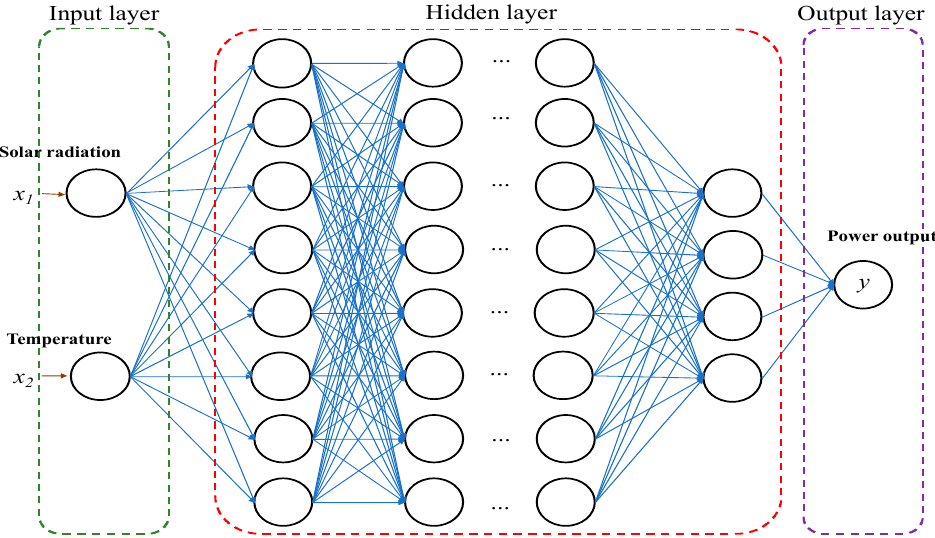
Figure 6. Forecast model based on artificial neural networks (ANN).